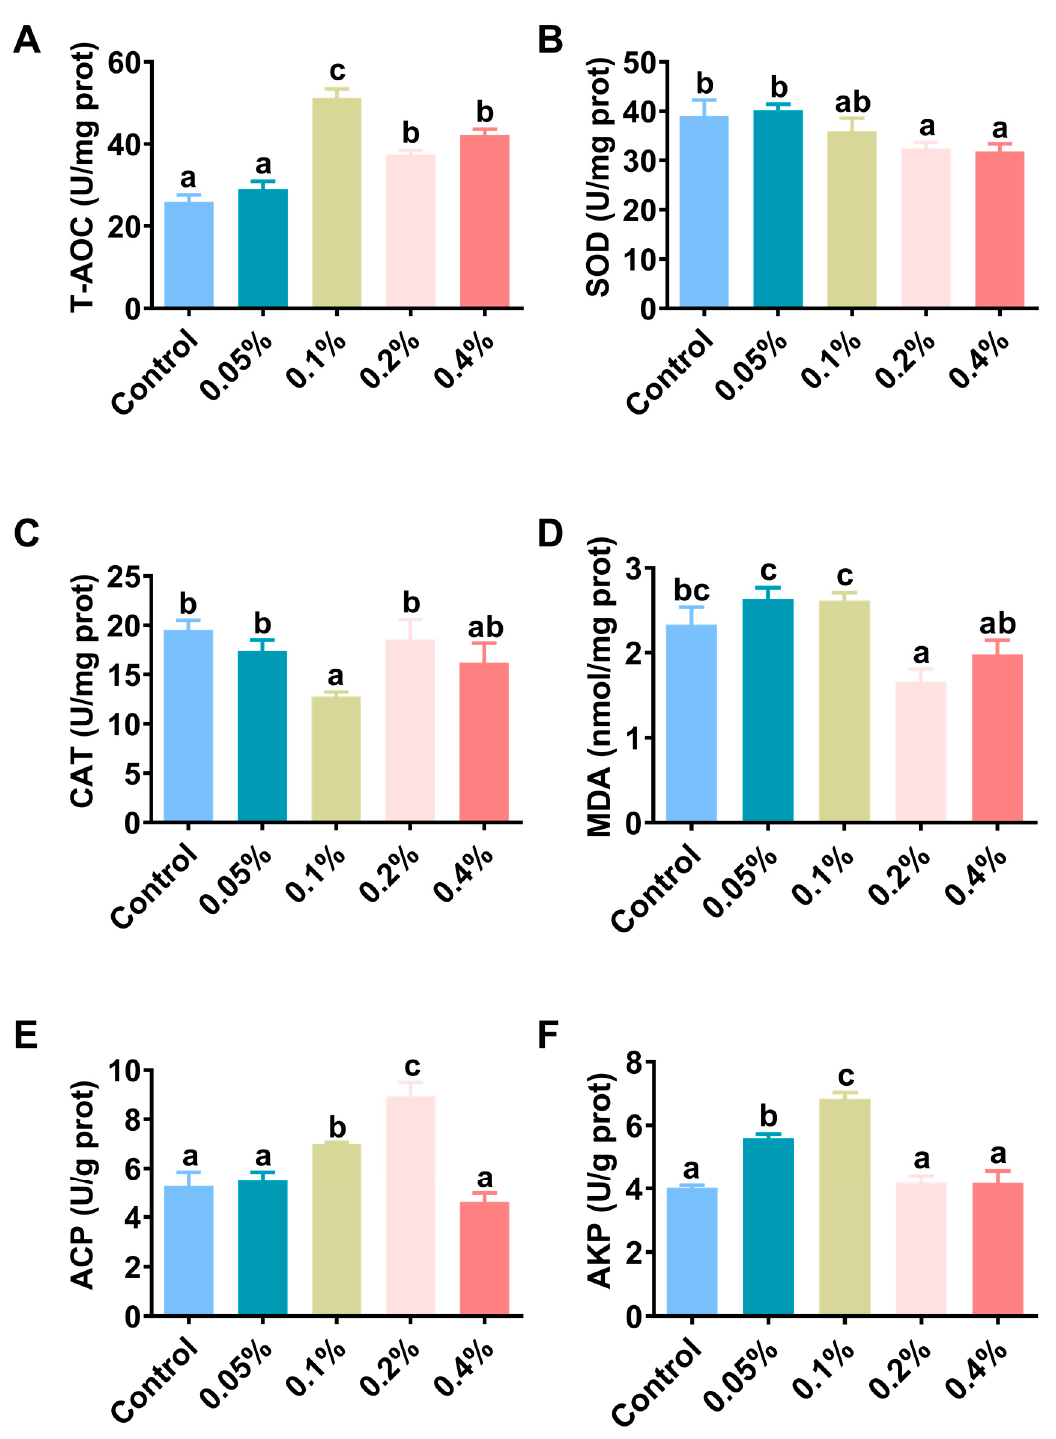
Figure 3. Effects of different doses of β -glucan on the ( A ) total antioxidant capacity, ( B ) superoxide dismutase, ( C ) catalase, ( D ) malondialdehyde content, ( E ) acid phosphatase and ( F ) alkaline phos- phatase of Juvenile L. vannamei . Different letters indicate significant differences ( p < 0.05) among groups. All data are expressed as the mean ± SE ( n = 4).